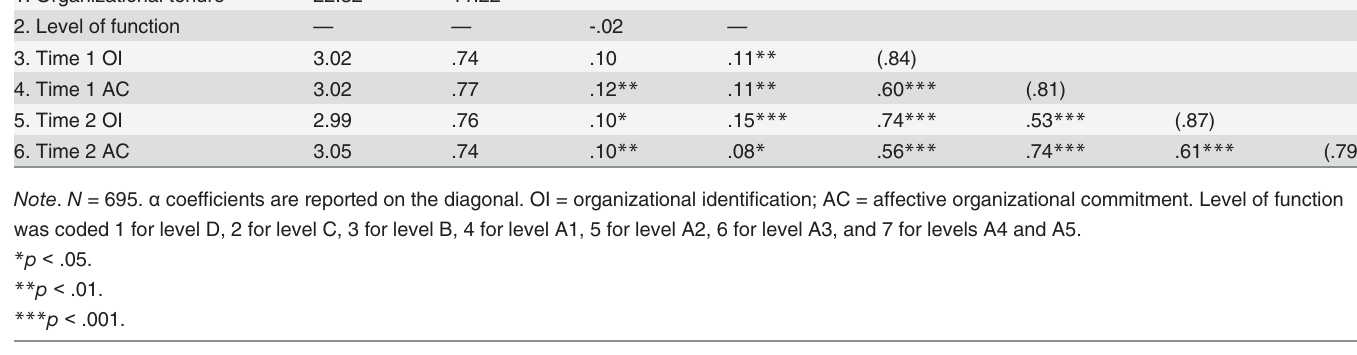
Table 1. Study 1: Descriptive Statistics and Intercorrelations Among Variables.